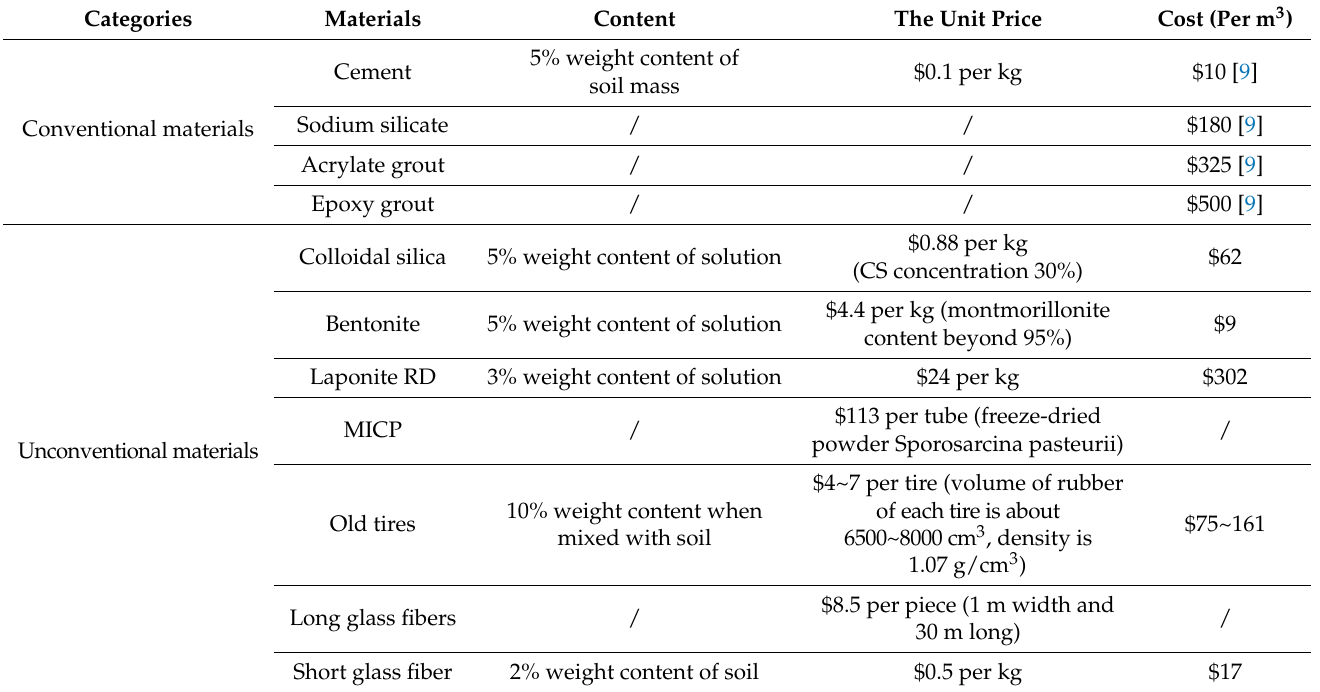
Table 2. Comparison of cost performance of different